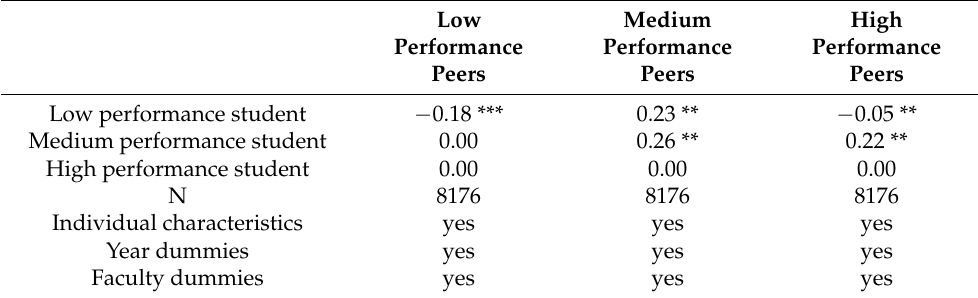
Table 4. Effects of heterogeneous peers according to student’s academic performance in Calculus I—OLS. High Medium Low Performance Performance Performance Peers Peers Peers Low performance student − 0.18 *** 0.23 ** − 0.05 ** Medium performance student 0.00 High performance student 8176 Individual characteristics yes yes yes Year dummies yes yes yes Faculty